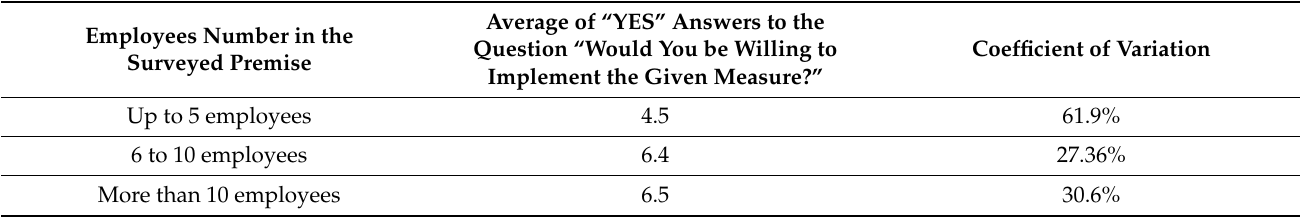
Table 5. Average number of approvals in the surveyed premises and coefficient of variation among the responses.